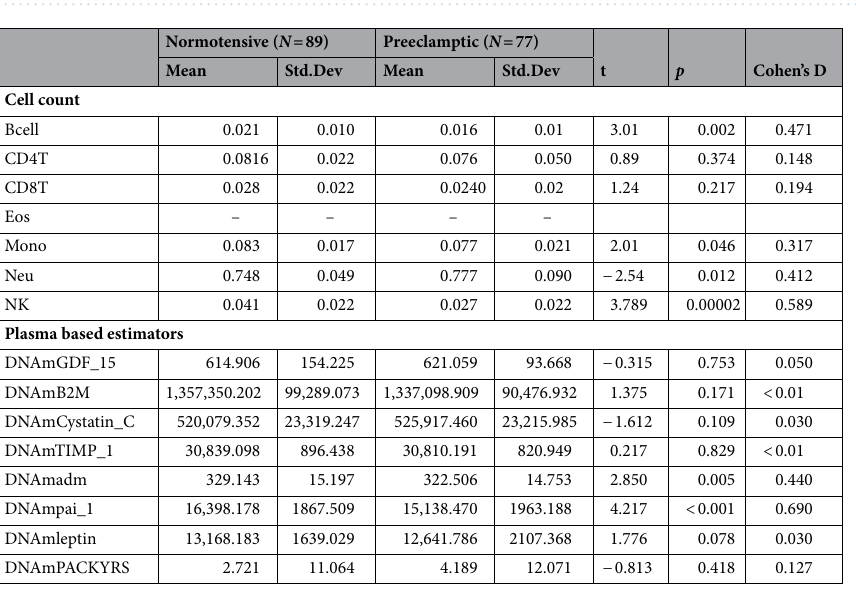
Figure 5. Intrinsic epigenetic age acceleration (IEAA), which represents the residuals from regressing chronological age on each DNAmAge measure adjusted for estimated cell type.